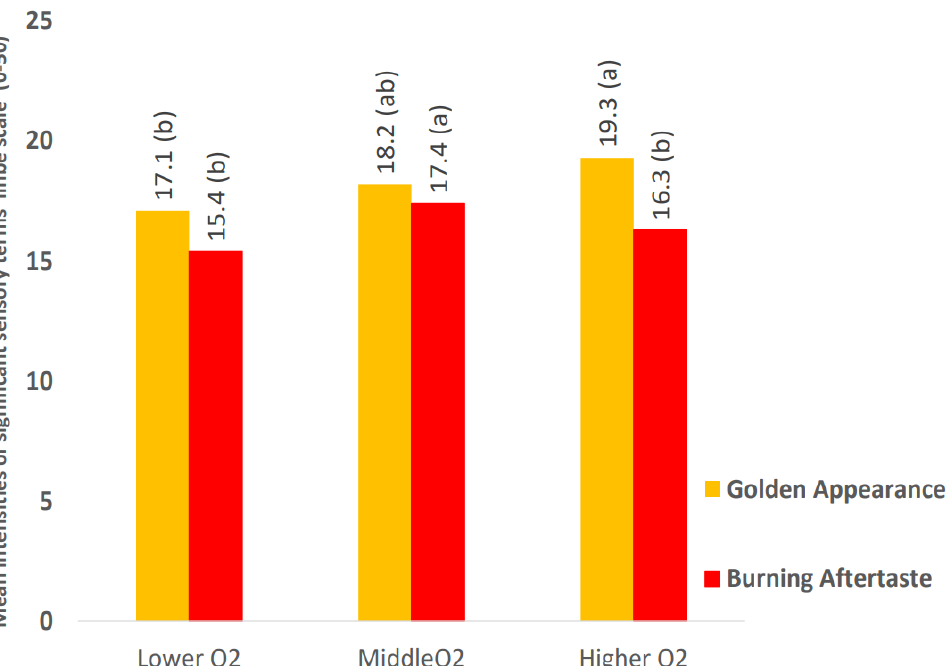
Figure 4. Mean intensities of significant sensory terms of main effect oxygen level. Note: Significance at p < 0.05, attribute means showing the same letter (a or b) are not significantly different.